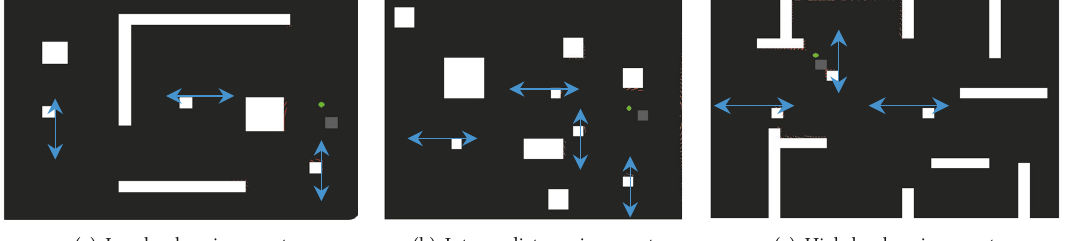
Figure 3: Dynamic